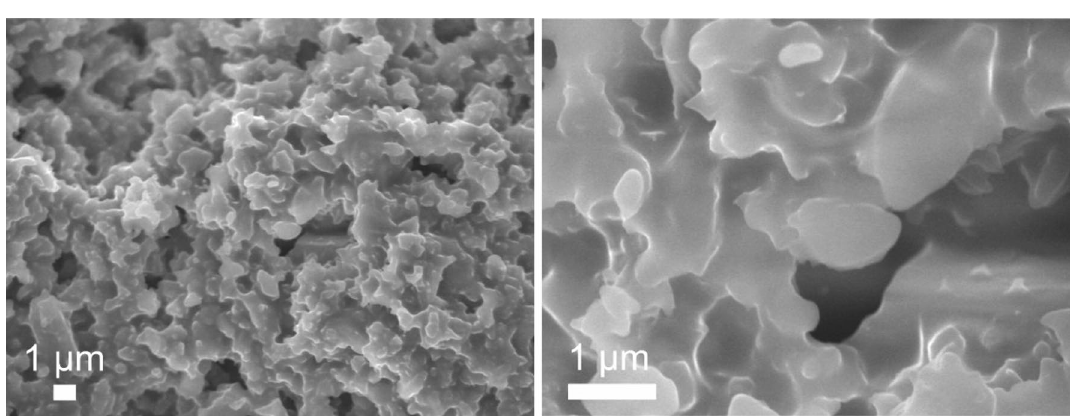
Figure 2. Crystal packing of title compound viewed along the a -axis (hydrogen bonds are represented by dashed lines).